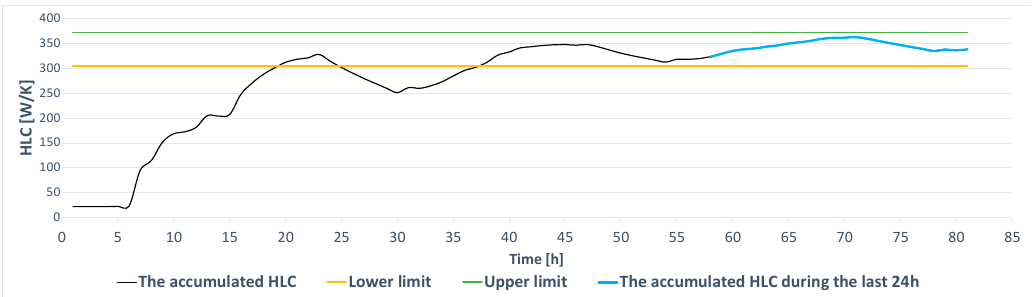
Figure 3. Solar gains (S a V sol ), space-heating systems’ heat input (Q) and total electricity consumption, including synthetic occupants’ generation (K): ( a ) for the whole dataset in Loughborough, ( b ) for period 1 in Loughborough.